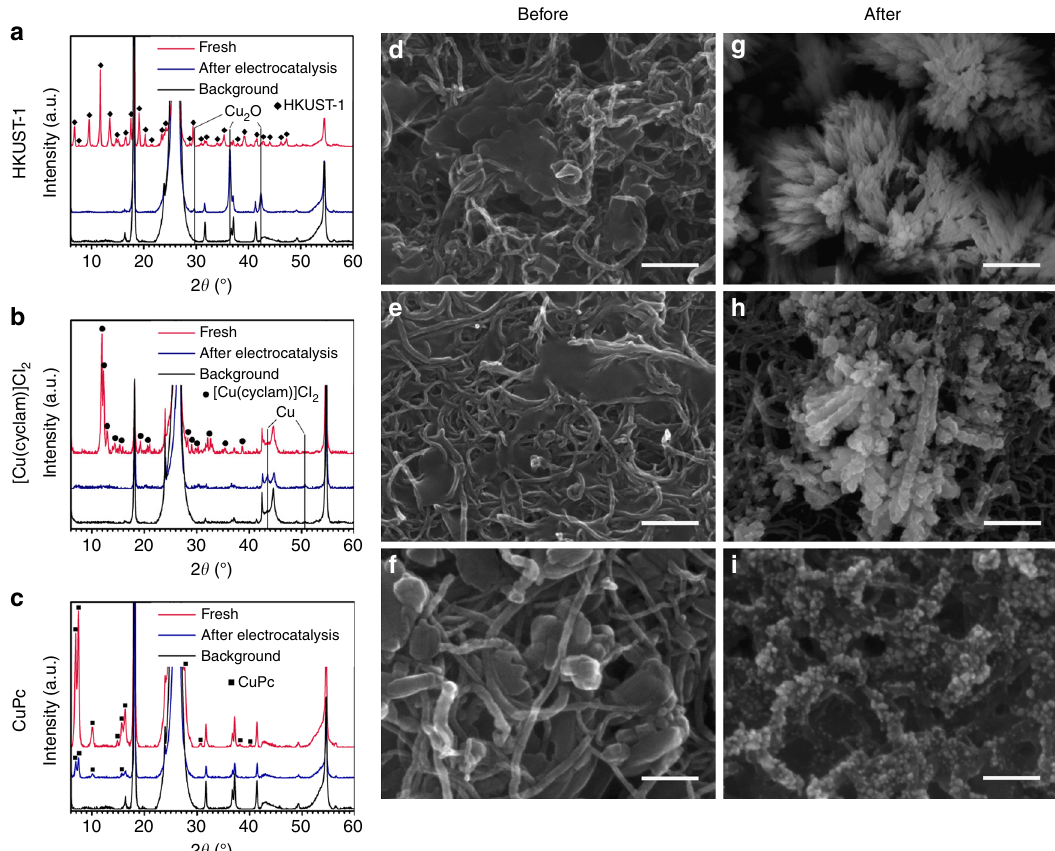
Fig. 3 XRD and SEM characterizations of the three catalyst materials before and after electrolysis. XRD patterns of a HKUST-1, b [Cu(cyclam)]Cl 2 , and c CuPc before and after electrocatalysis. The background diffraction patterns are from carbon paper substrates. SEM images of the d , g HKUST-1, e , h [Cu (cyclam)]Cl 2 , and f , i CuPc catalyst materials d – f before and g – i after electrocatalysis. Scale bars: d , e , g , h 200 nm and f , i 100